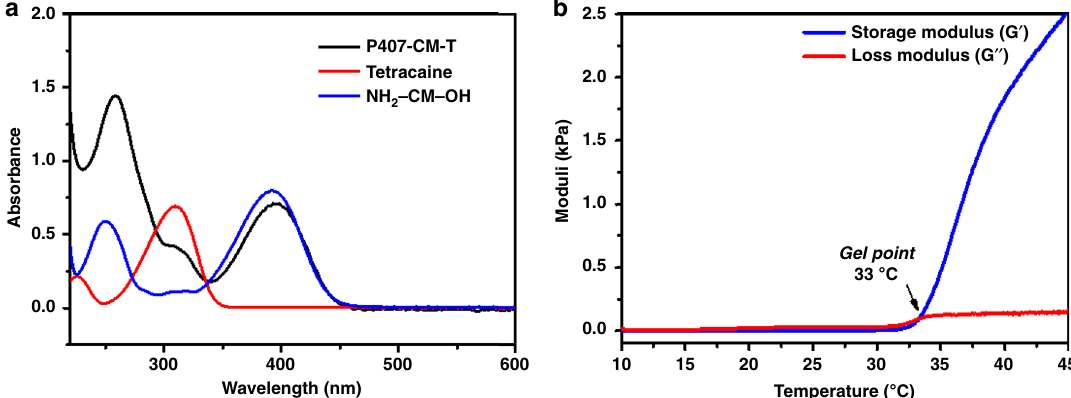
Fig. 2 Physical properties of P-CM-T. a UV-vis absorption spectra of aqueous solutions of P-CM-T (0.3mgmL − 1 , black line), tetracaine hydrochloride (0.01 mgmL − 1 , red line) and NH 2 -CM-OH (0.01 mgmL − 1 , blue line). b Rheology of 20wt% P-CM-T as a function of temperature (blue line: G ′ ; red line: G ″